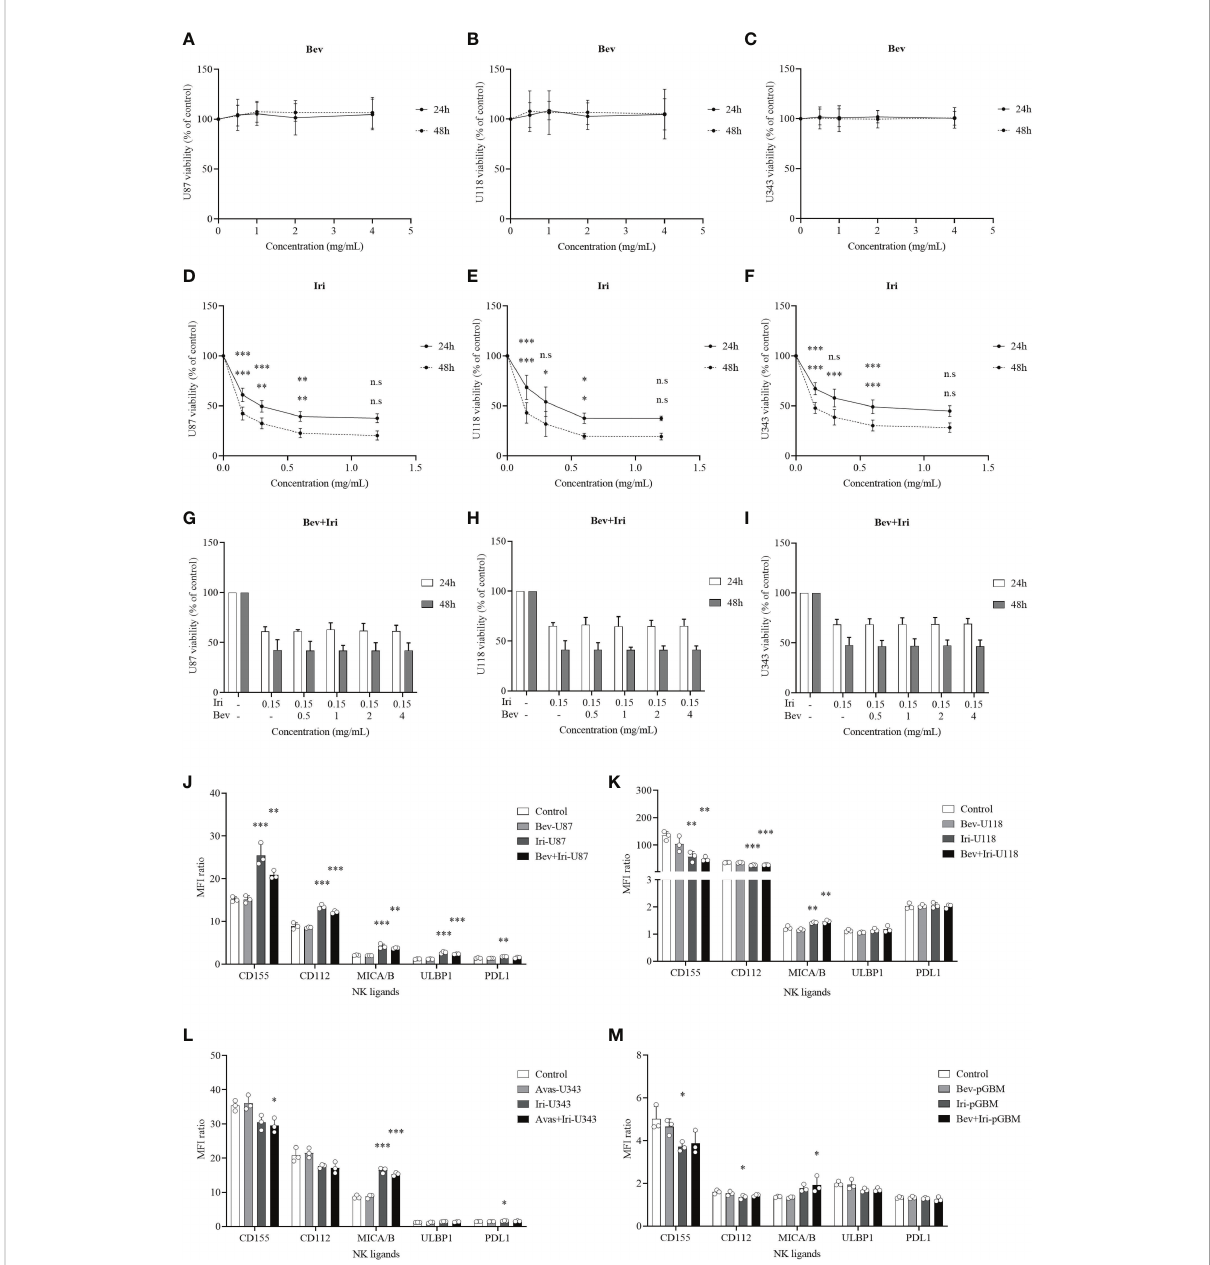
FIGURE 1 Effects of Bev and Iri on the proliferation of GBM cells in vitro . GBM cells (U87, U118, and U343 cells) were treated with Bev and Iri separately or in combination of according to the increased concentration of these two drugs (0.5, 1, 2, and 4 mg/mL for Bev and 0.15, 0.3, 0.6, and 1.2 mg/ mL for Iri). After 24 and 48 h, cell viability was determined by MTT assay and IC 50 was calculated to determine the concentration of drugs that exhibited 50% cell viability. The viability of untreated cell cultures was set at 100% (A – I) . Moreover, the expression of NK ligands on GBM cells such as U87, U118, U343, and pGBM and the effects of Bev (0.5 mg/mL) and Iri (0.15 mg/mL) on their expression was clari fi ed using fl ow cytometry. (J – M) Data were presented as MFI ratio calculated by dividing the MFI of the positive cells (stained cell population) by that of the negative cells (live cell population). FMO: live cells. U87, U118, and U343: human GBM cell lines; pGBM: primary GBM cells; Bev: bevacizumab; Iri: irinotecan. All data are shown as mean ± SD. p< 0.05 (*), p< 0.001 (**), p< 0.0001 (***). n.s, no signi fi cant